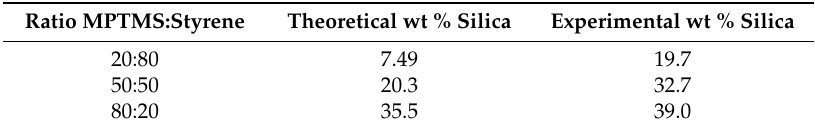
Table 1. Experimentally obtained and theoretical silica content at different mixing